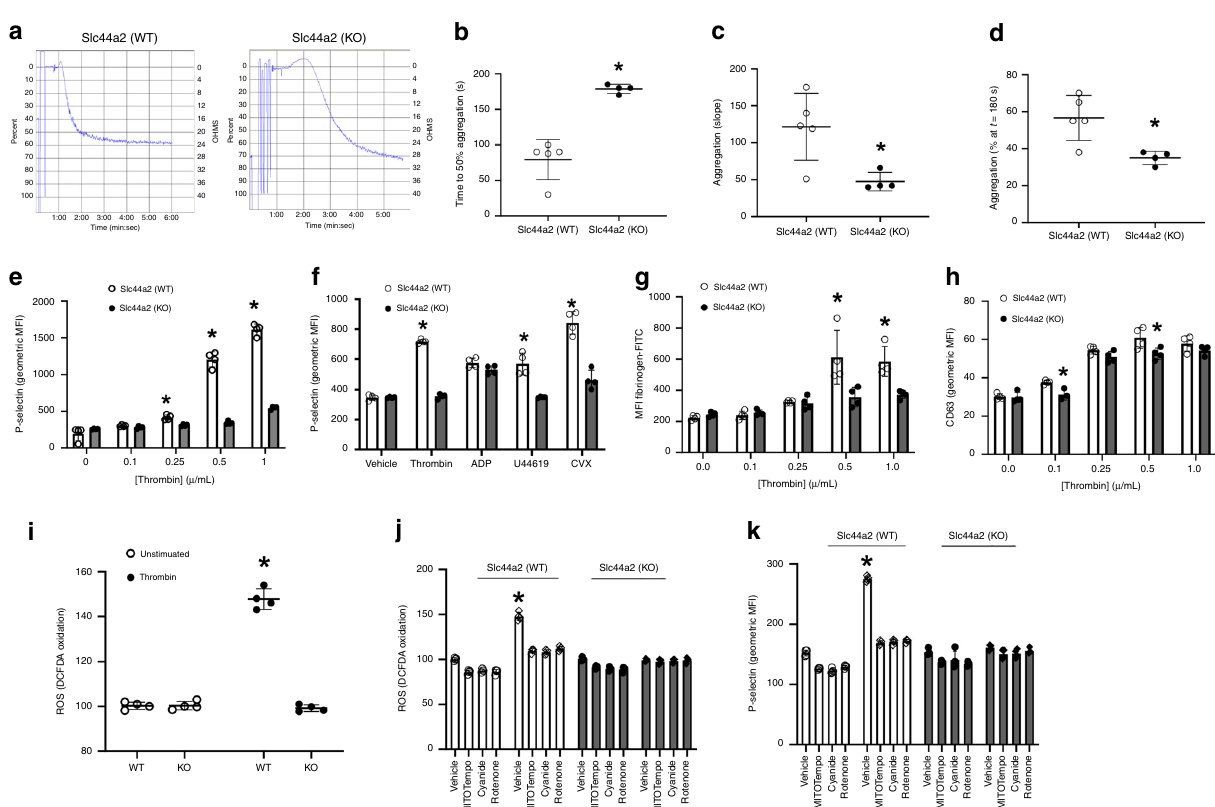
Fig. 2 Slc44a2 regulates murine platelet activation ex vivo. a – d Platelet aggregation after treatment with 0.5 µ /mL thrombin was measured by light transmission aggregometry. n = 4 biologically independent samples ±S.D. * P < 0.05 in a two-tailed Student ’ s t test. e Platelet externalization of P-selectin after thrombin stimulation was measured by fl ow cytometry. n = 3 biologically independent samples ±S.D. * P < 0.05 in a two-tailed Student ’ s t test. f Platelet externalization of P-selectin after treatment with various agonists (0.5 µ /mL thrombin, 5 µ M ADP or U46619, or 0.5 ng/mL convulxin). n = 3 biologically independent samples ±S.D. * P < 0.05 in a two-tailed Student ’ s t test. g Platelet activation of GPIIbIIIA after 0.5 µ /mL thrombin treatment was measured by fl ow cytometry of FITC- fi brinogen binding. n = 3 biologically independent samples ±S.D. * P < 0.05 in a two-tailed Student ’ s t test. h